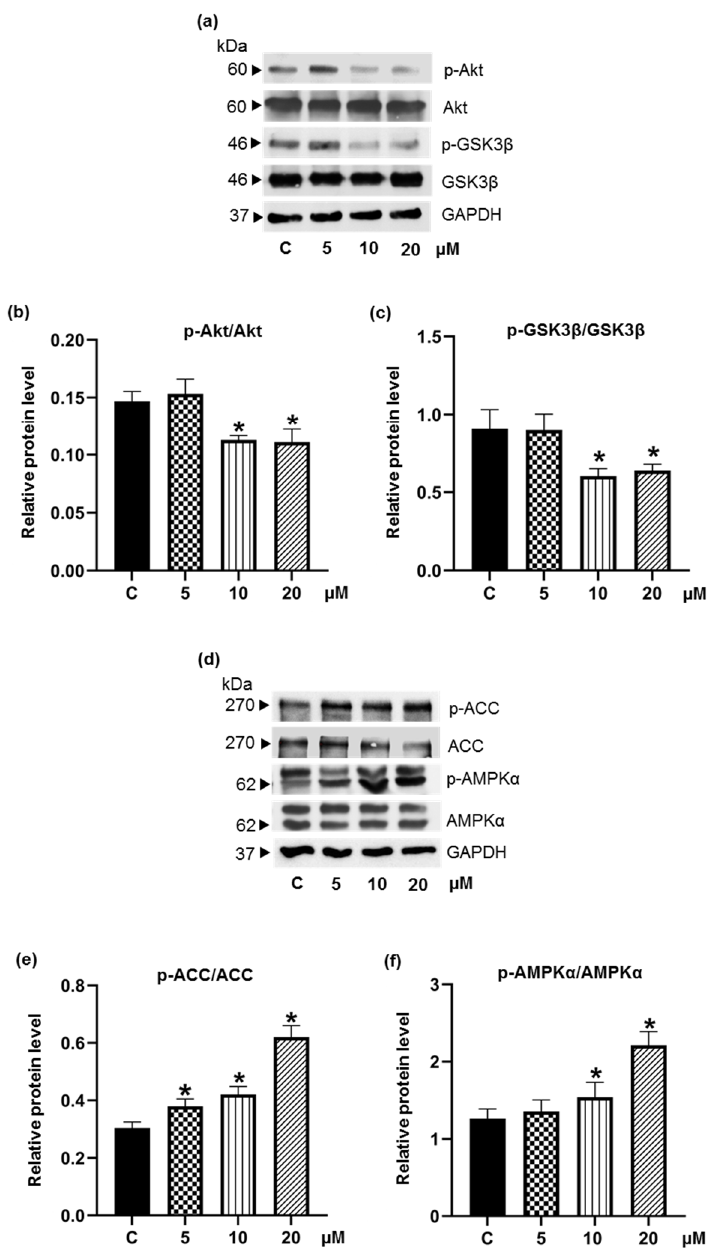
Figure 6. Effect of pinostrobin on the Akt-related signaling pathways. ( a ) Western blotting revealed the alteration of Akt and GSK3 β signals in 3T3-L1 cells in the presence of pinostrobin for 48 h of the early differentiating process. There was significant reduction of ( b ) p-Akt/Akt and ( c ) p-GSK3 β /GSK3 β levels in cells treated with 10 and 20 µ M pinostrobin. ( d ) The modulation on AMPK-ACC pathway, a downstream of Akt signal, was also detected in pinostrobin-treated 3T3-L1 cells. Activation of AMPK-ACC signal was evidenced by upregulated ( e ) p-AMPK α /AMPK α and ( f ) p-ACC/ACC levels. Data represent the mean ± SD. * p < 0.05 compared with vehicle control cells (C) treated with 0.5%